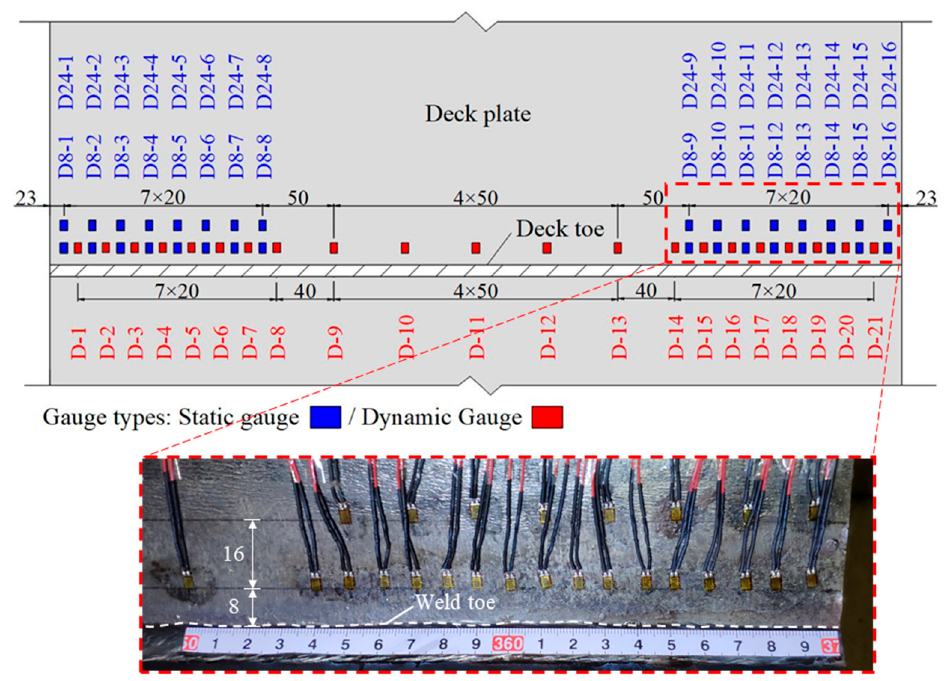
Figure 4. Strain gauges installed on specimens.